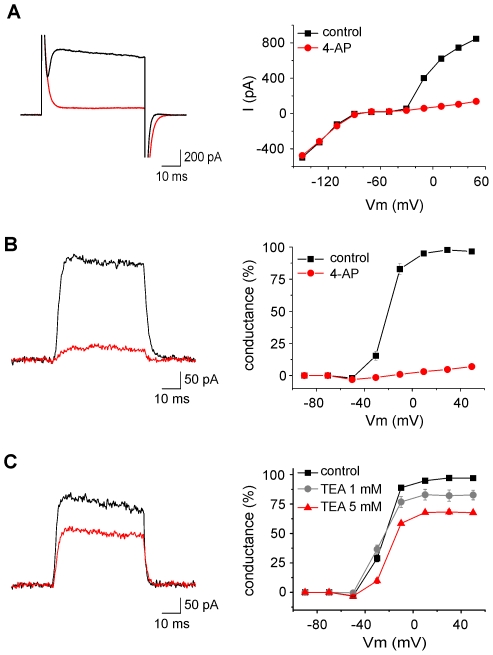
Effects of broad spectrum blockers of potassium channels on the outward rectifying current expressed by microglia 48 h after the induction of status epilepticus.A Example of the current (left panel) induced by a voltage step from −70 to +30 mV in control (black trace) and after perfusion of 4-AP (1 mM, red trace), and the I/V relationships in the same cell (right panel). Note that 4-AP almost completely abolished the outward rectifying currents without affecting the inward currents. B–C Examples of leak subtracted currents induced by a voltage step from −70 to +40 mV in control (black trace) and after 4-AP 1 mM (B, red trace) or TEA 5 mM (C). The leak conductances of the cells in B and C were 585 and 256 pS, respecitively. The graphs on the right represent the conductance, normalized to its maximum value, as a function of membrane potential and its inhibition induced by 4-AP (B, n = 8), TEA (C) 1 mM (n = 9) and 5 mM (n = 7).